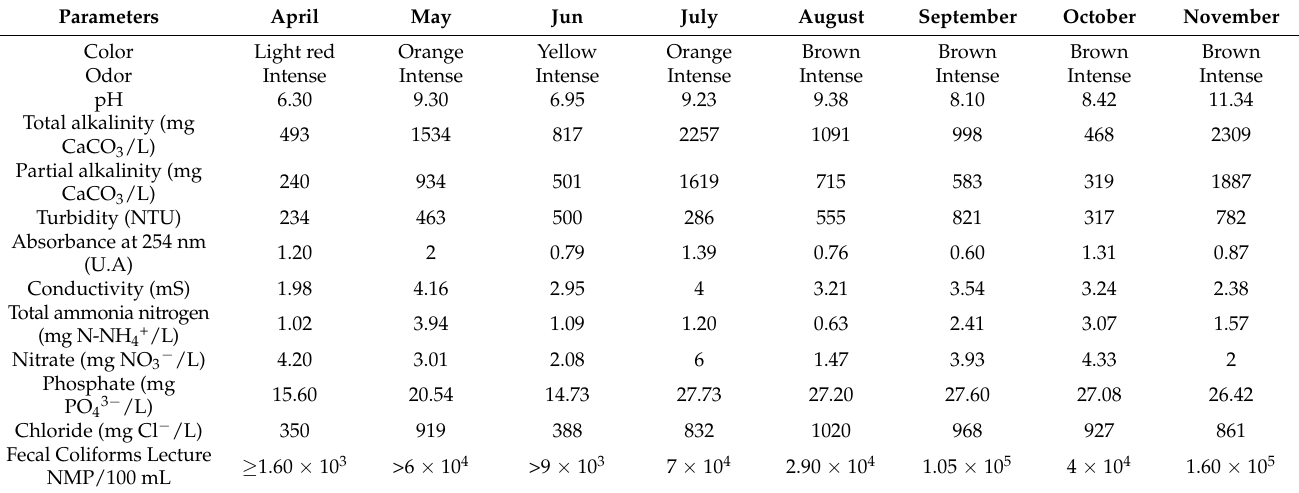
Table 2. Parameters monitored in winery wastewater over